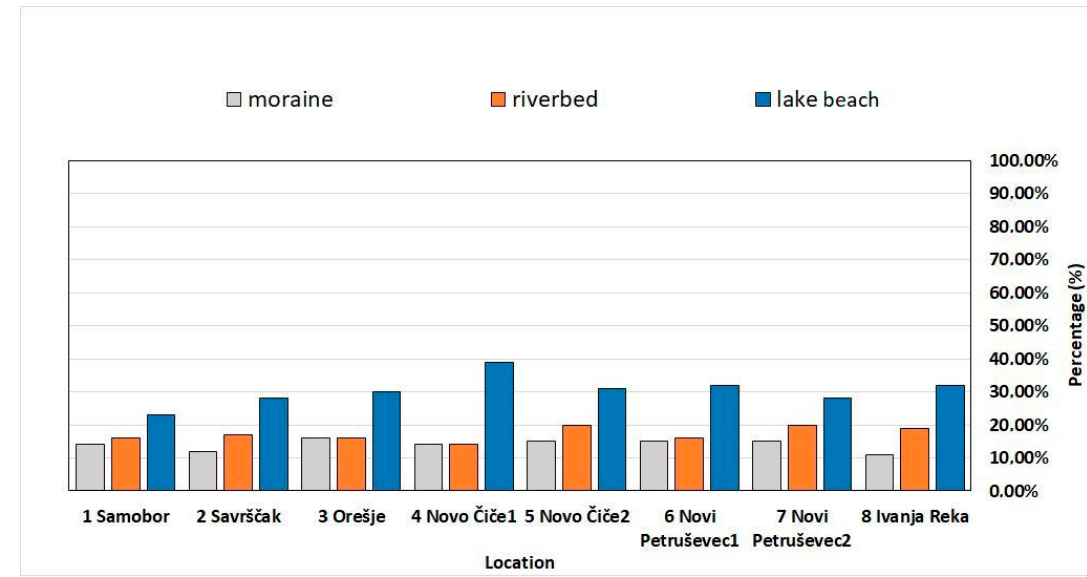
Figure 16. Tentatively attributed original sedimentary environments at locations.